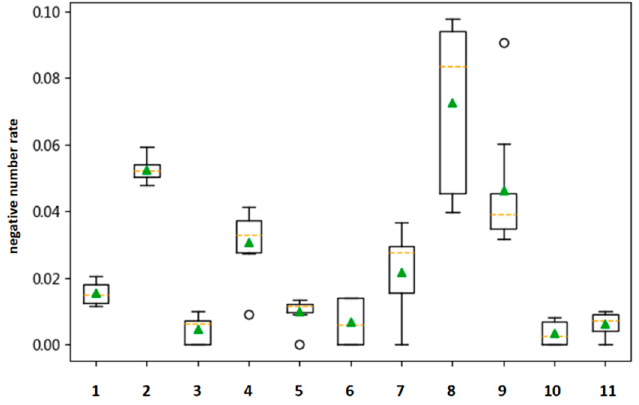
Figure 6. Abnormal negative data of each company (11 companies in total).